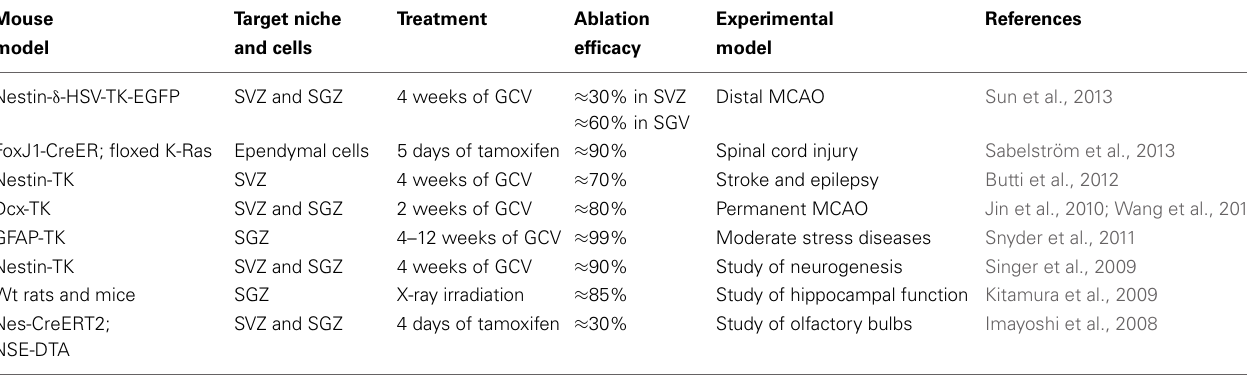
Table 1 | Newly developed mouse models to study the role of neurogenesis by specific ablation of different types of